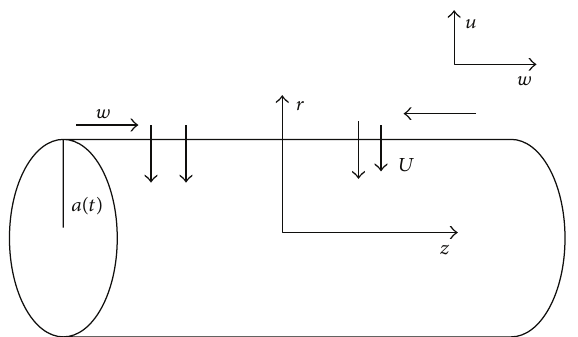
Figure 1: A schematic model of flow in an expanding cylinder with time dependent